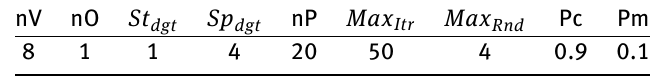
Table 23: VSSCGA Settings for Himmelblau’s function with 8 variables